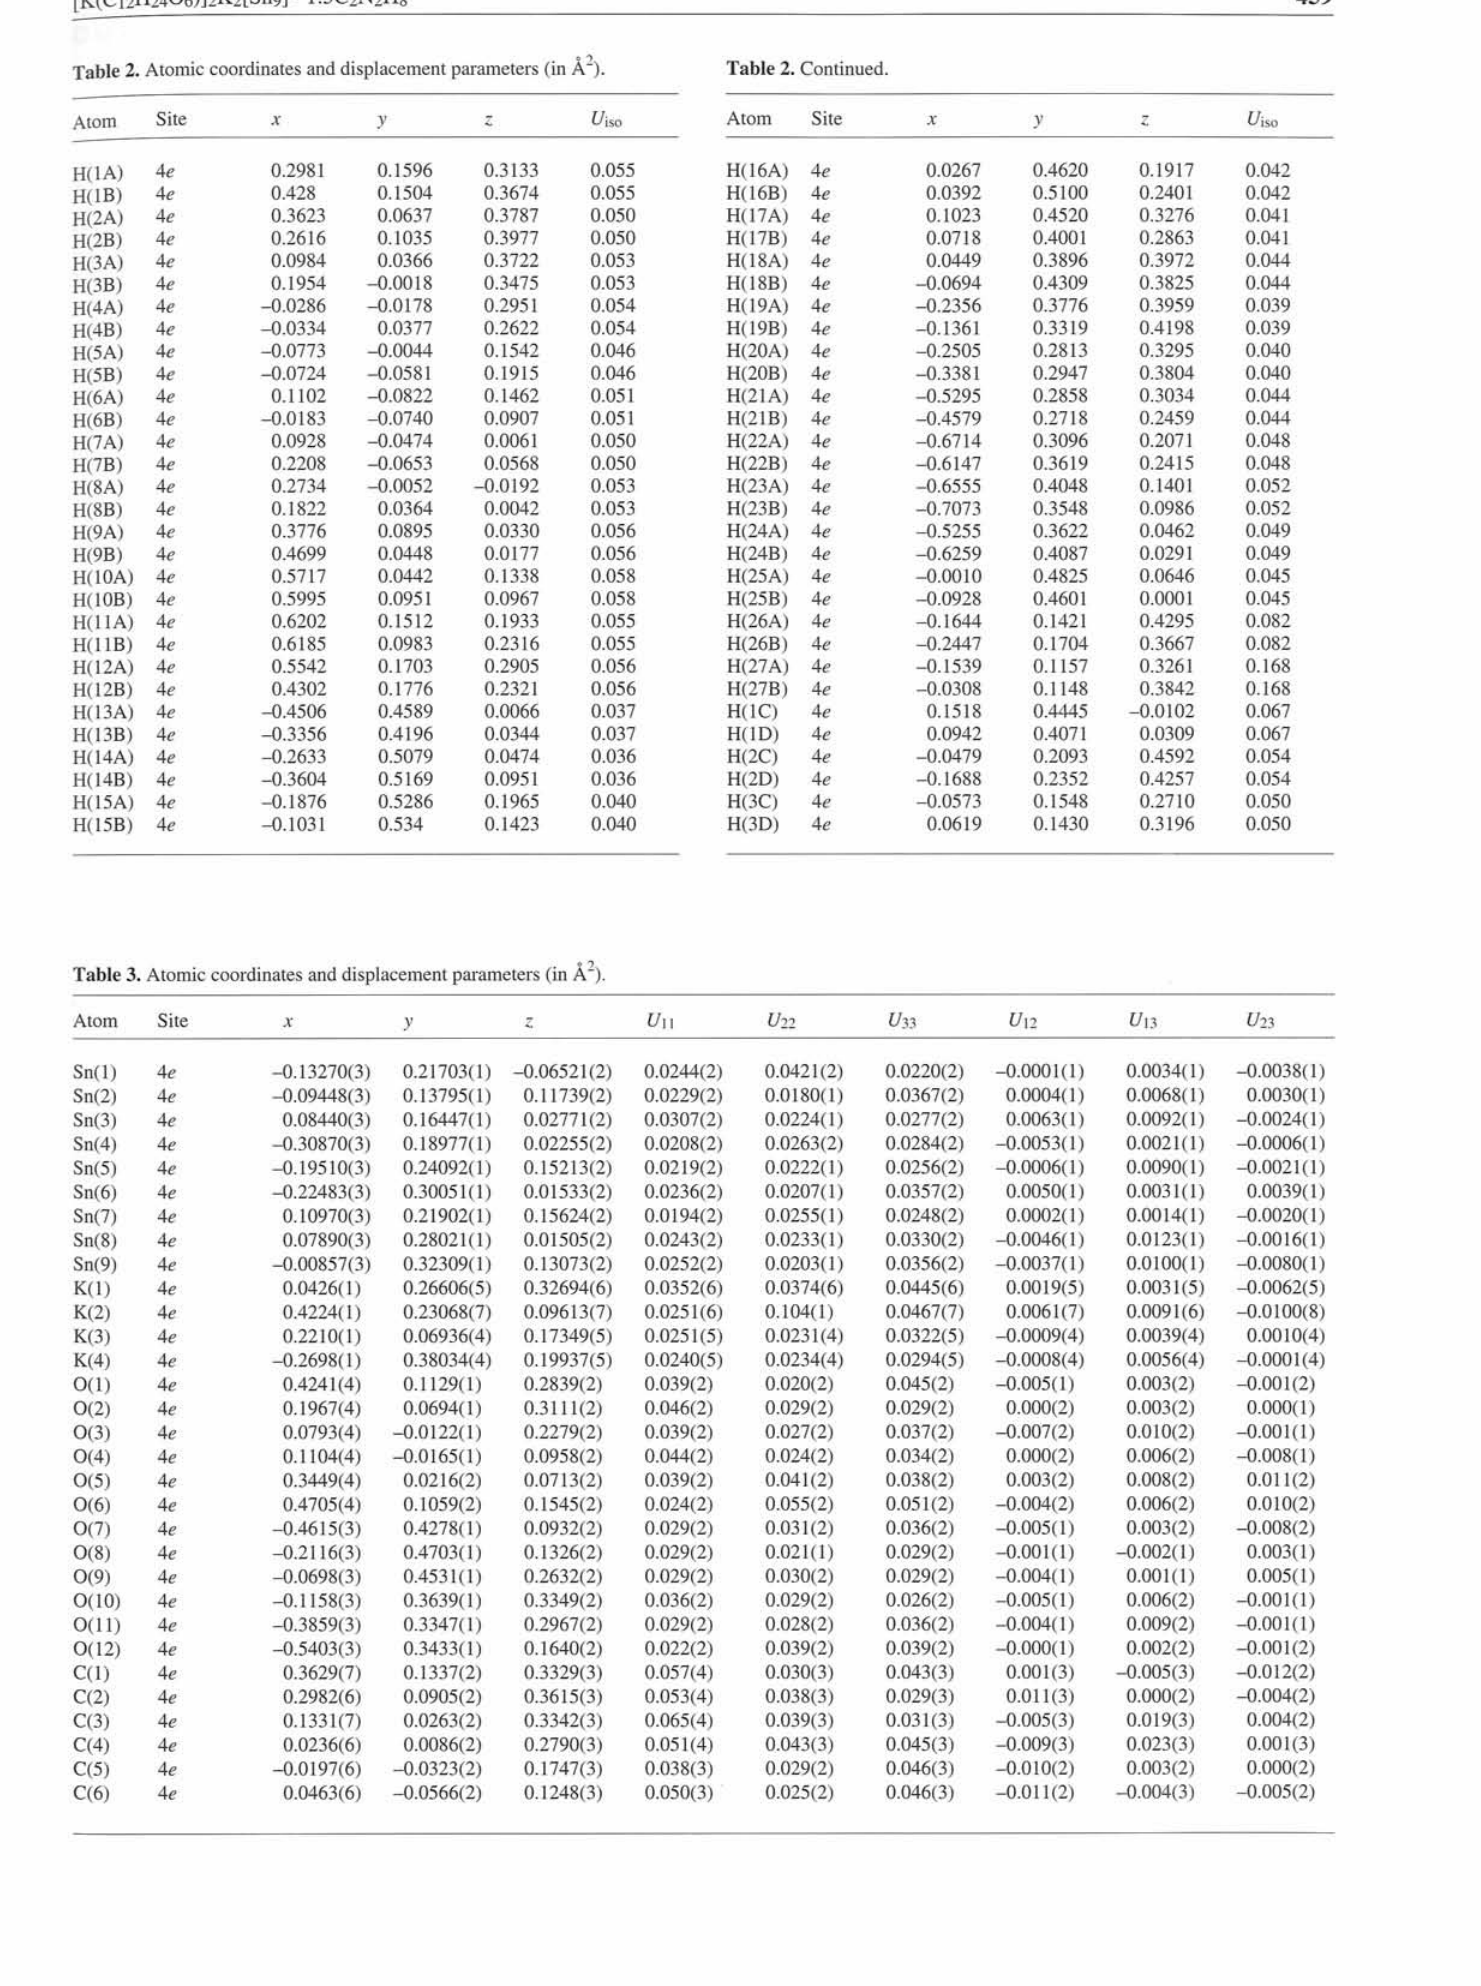
o 9 Table 3. Atomic coordinates and displacement parameters (in A